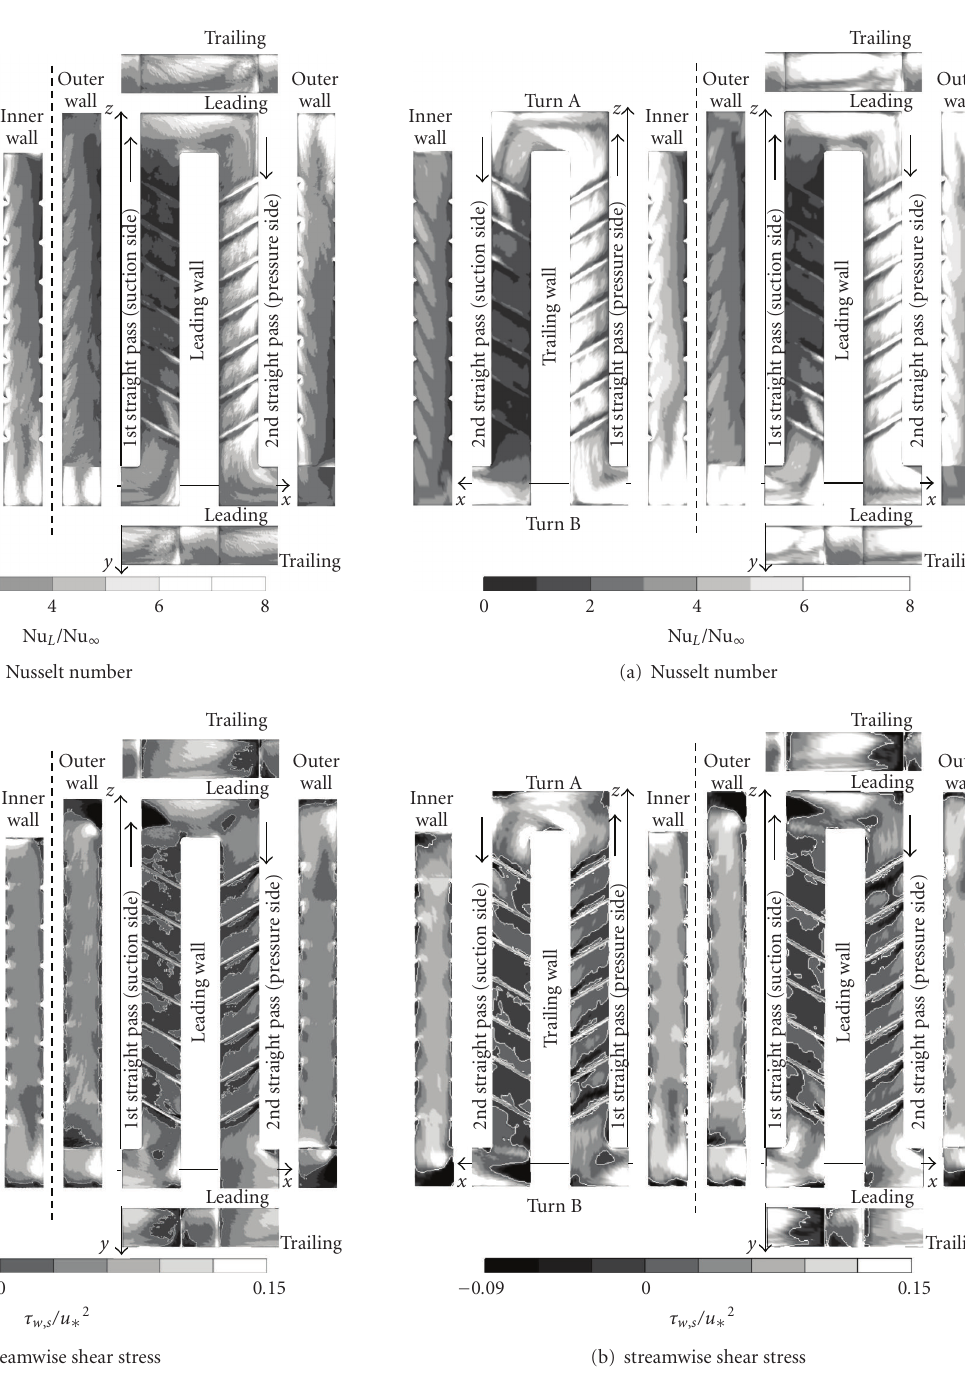
Figure 3: Time-averaged profiles of Nusselt number and stream- wise component of wall shear stress (60 ◦ rib NP, Re ∗ = 1000, Ro ∗ = 1, and Ra ∗ =